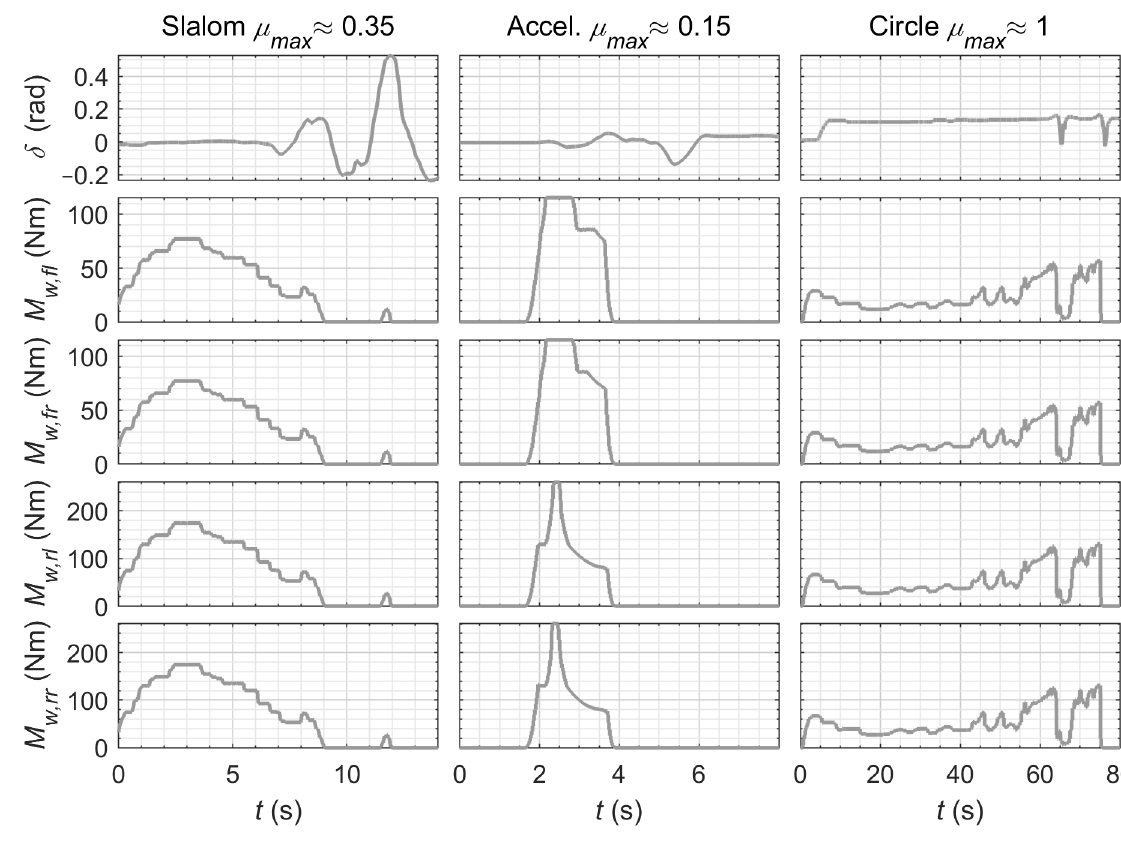
Figure A1. Training data: system inputs steering angle and motor